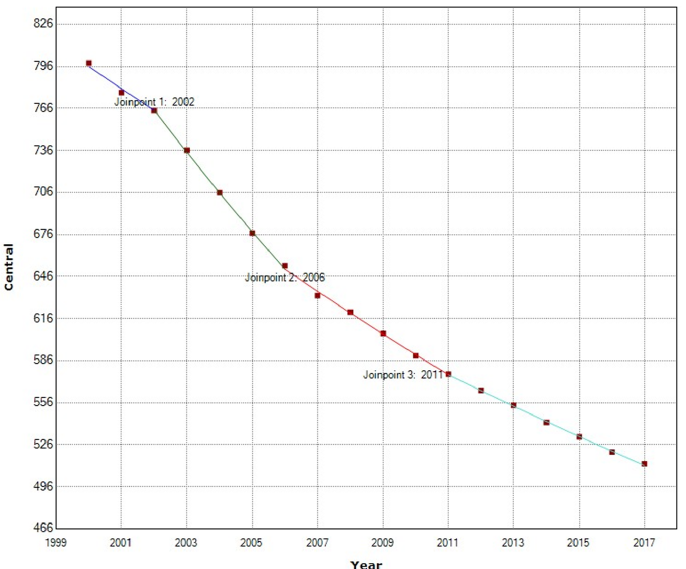
Figure 7. Maternal mortality trends in Central Africa (2000–2017) indicate joinpoints at the transitions between colored lines. In the South African region, the overall MMR decreased from 468 to 218 per 100,000 births. The South African region has the highest MMR reduction, with a reduction of − 53.42%. We recorded a statistically significant annual decrease of –4.8% in the MMR, with three joinpoints in 2004, 2007, and 2013 (Figure 8). In the first period, MMR decreased with an APC of − 3.0%, then in the second period, 2004–2007, MMR decreased with an APC of − 4.7%. Later, from 2007–2013, there was a high APC decrease of − 6.0. This decrease is the greatest detected in this study. In 2013–2017, there was a deceleration with an APC of − 3.1%.